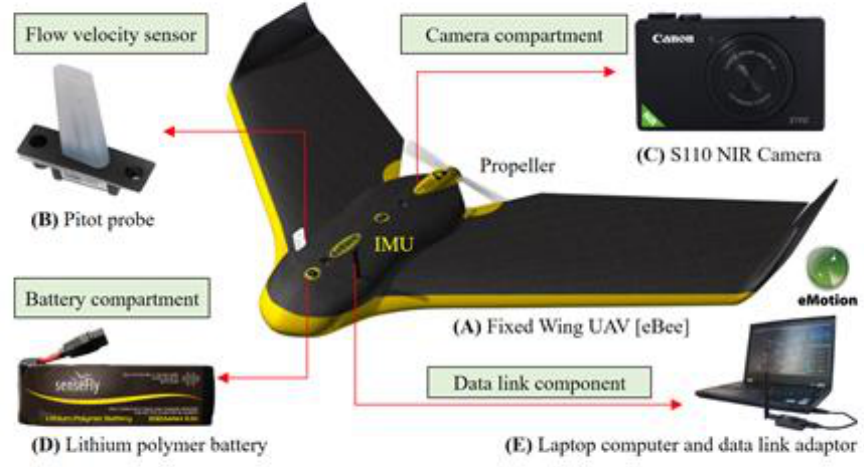
Figure 3. The main components of the unmanned aerial vehicle (UAV) and NIR Sensor. Table 1. On-site measuring instruments and observation conditions.